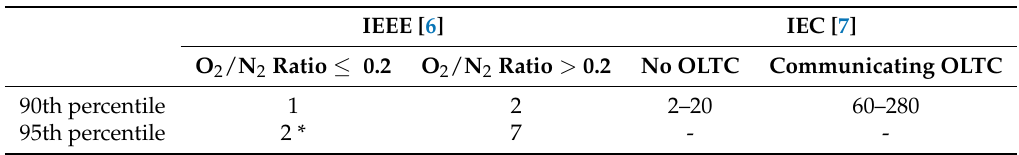
Table 2. Acetylene concentration limits (ppm).